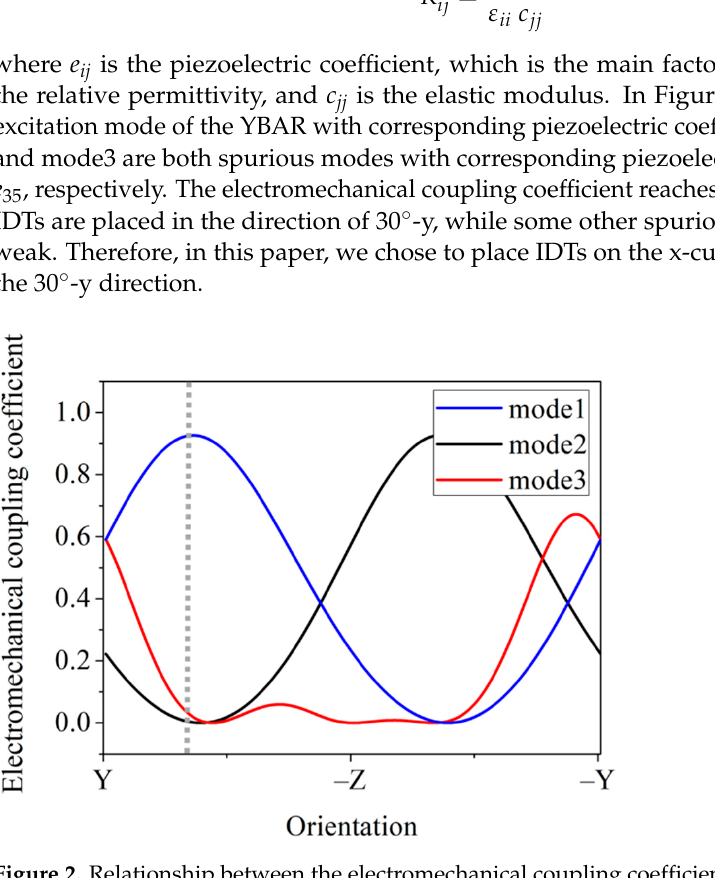
Figure 2. Relationship between the electromechanical coupling coefficient of an x-cut LiNbO 3 film and the orientation of IDTs placed on its top surface.